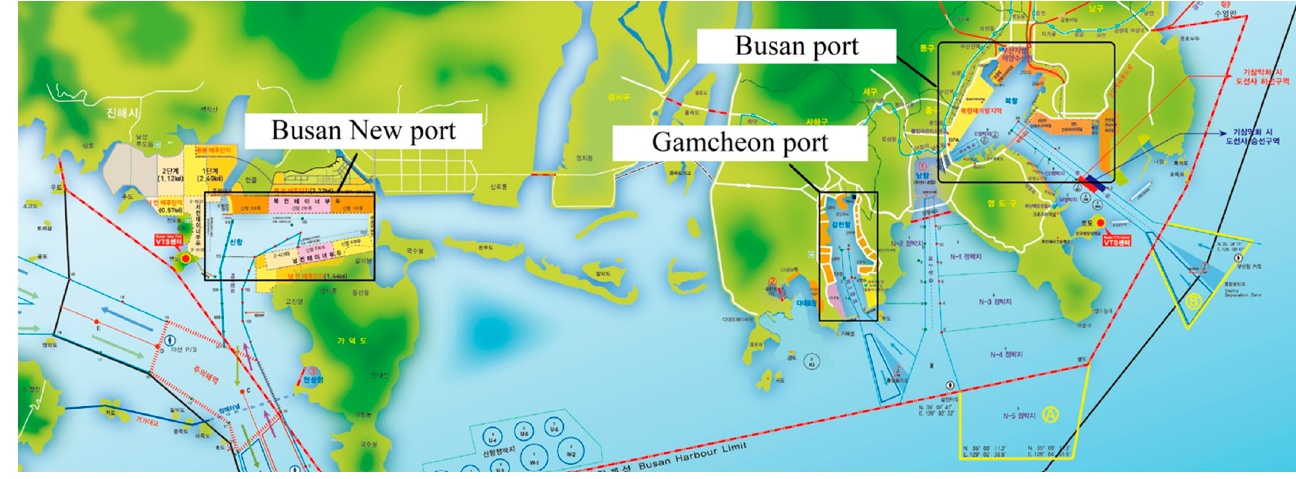
Figure 2. Study area